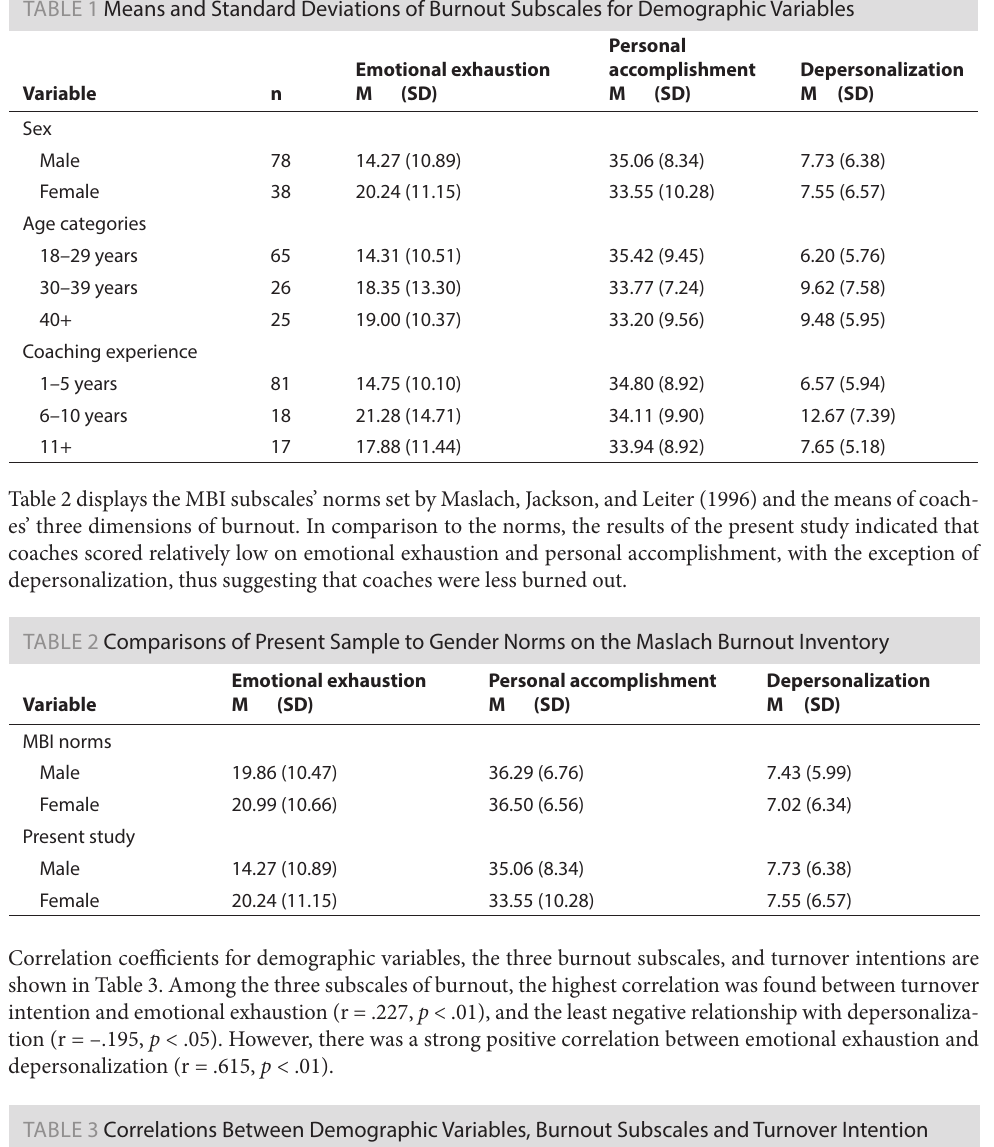
TABLE 1 Means and Standard Deviations of Burnout Subscales for Demographic Variables